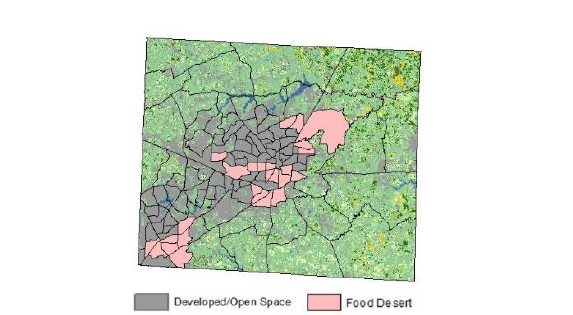
Figure 1a: Food deserts surrounded by undeveloped area/farms (represented by colors other than gray and pink) in Guilford County, North Carolina . Data source: USDA food desert mapping and USDA Cropland Data Layer If we further overlay individual household addresses (RTI international's U.S. synthetic household population) on the